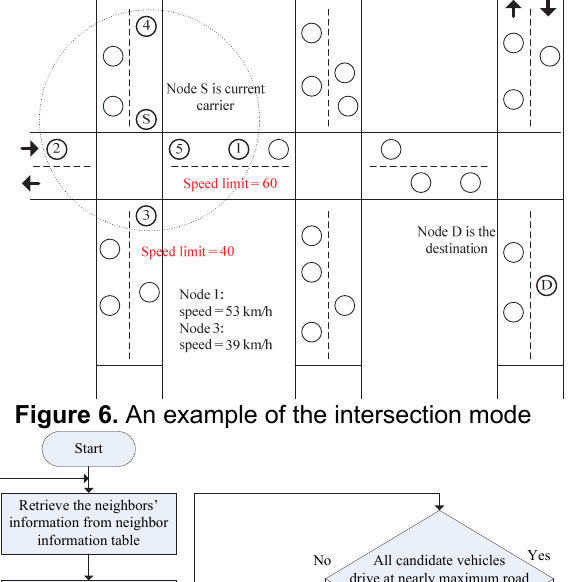
Figure 6. An example of the intersection mode